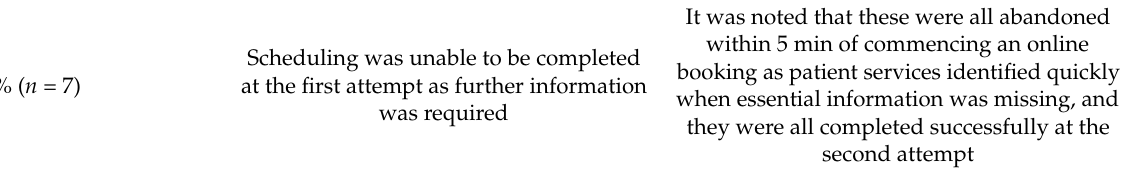
Table 3. Results from observing an online booking/as is process.